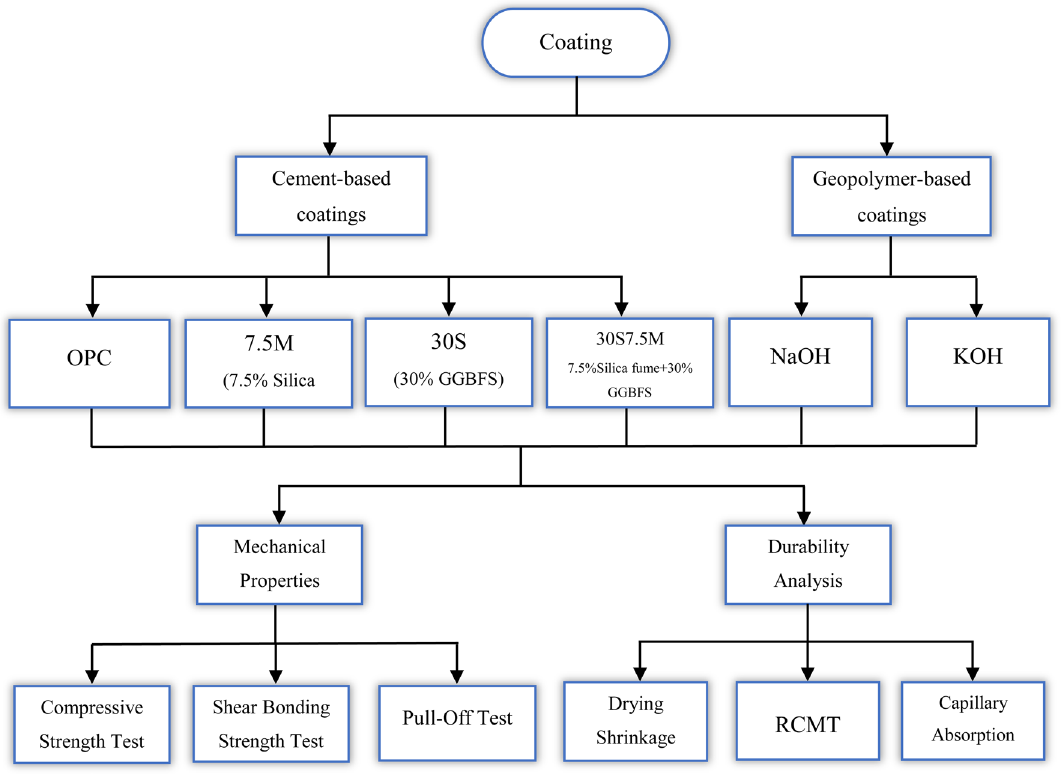
Fig. 1 The flowchart of the experimental